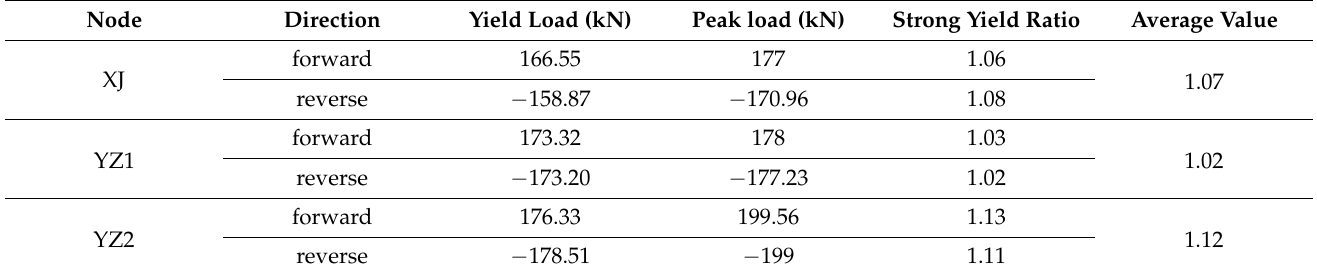
Table 3. The carrying capacity of the joints.